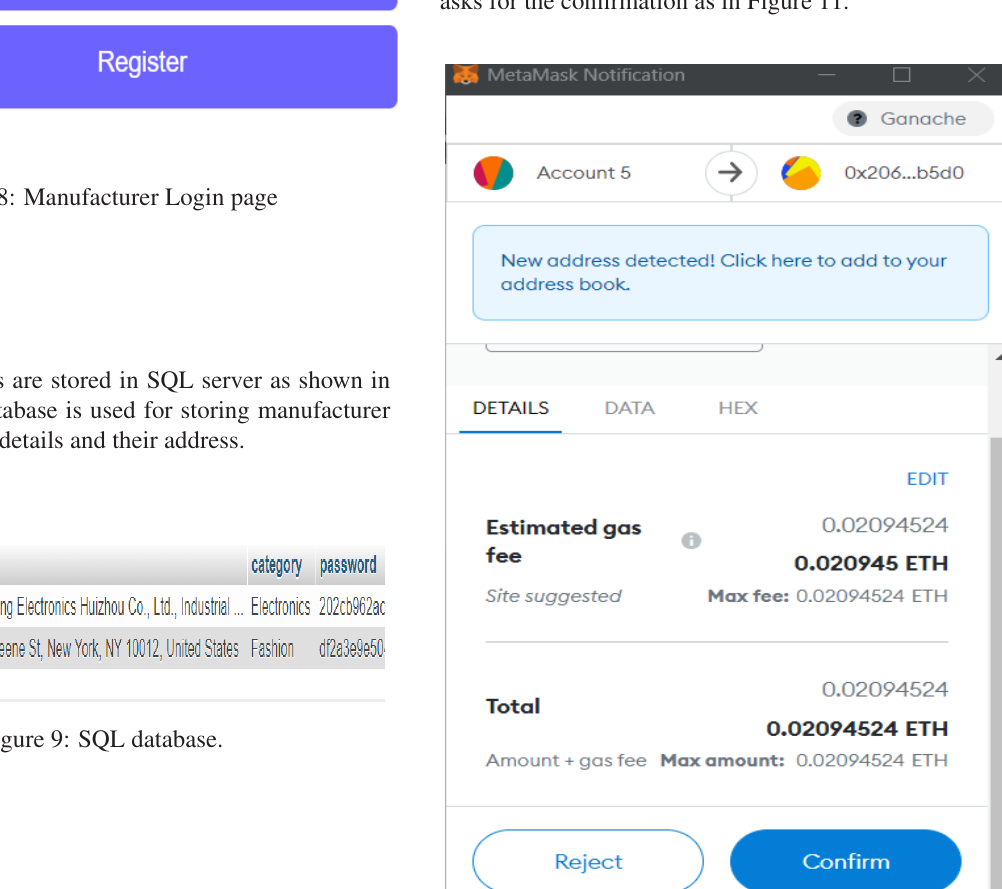
Figure 10: Manufacturer adding the details of the product.